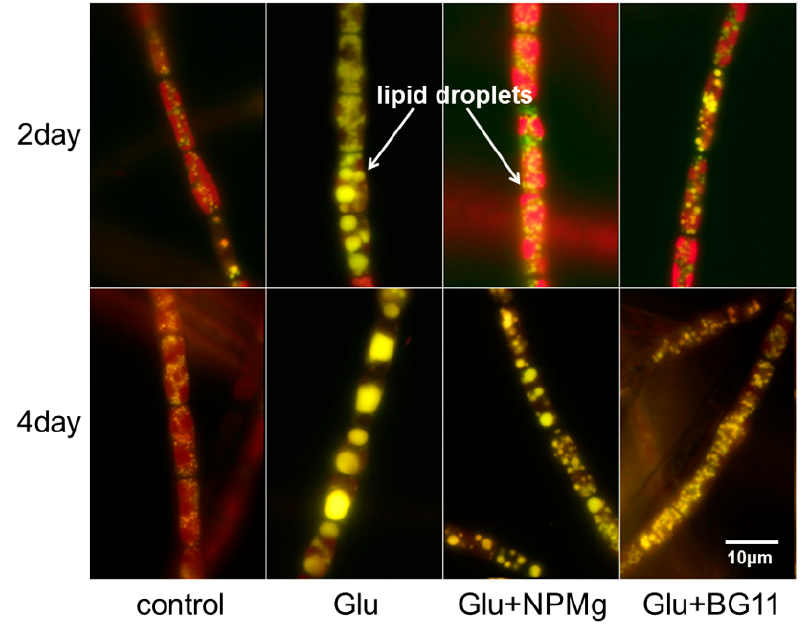
Figure3. Fluorescencemicroscopyexamination of T. minus indi ff erentmediumsundertheheterotrophic Figure 3. Fluorescence microscopy examination of T. minus in different mediums under the regime (stained with Nile heterotrophic regime (stained with Nile Red).